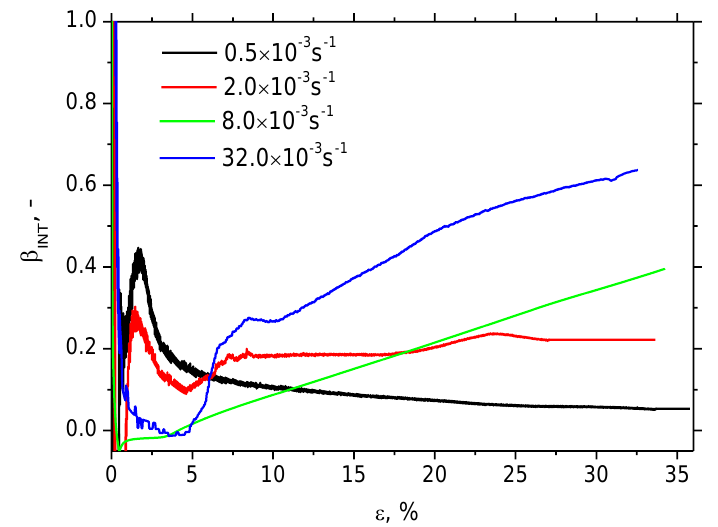
Figure 6. Evolution of β INT as a function of plastic strain and strain rate.